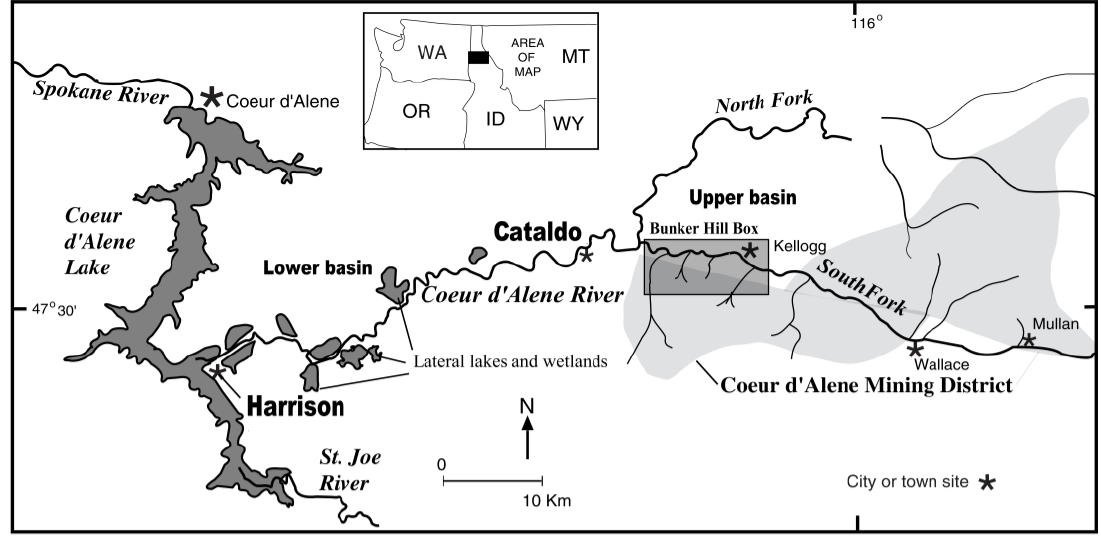
Figure 1. Upper and lower basins of the Coeur d’Alene River Basin, Idaho USA. Cataldo represents the transition point from the upper basin to the lower basin.